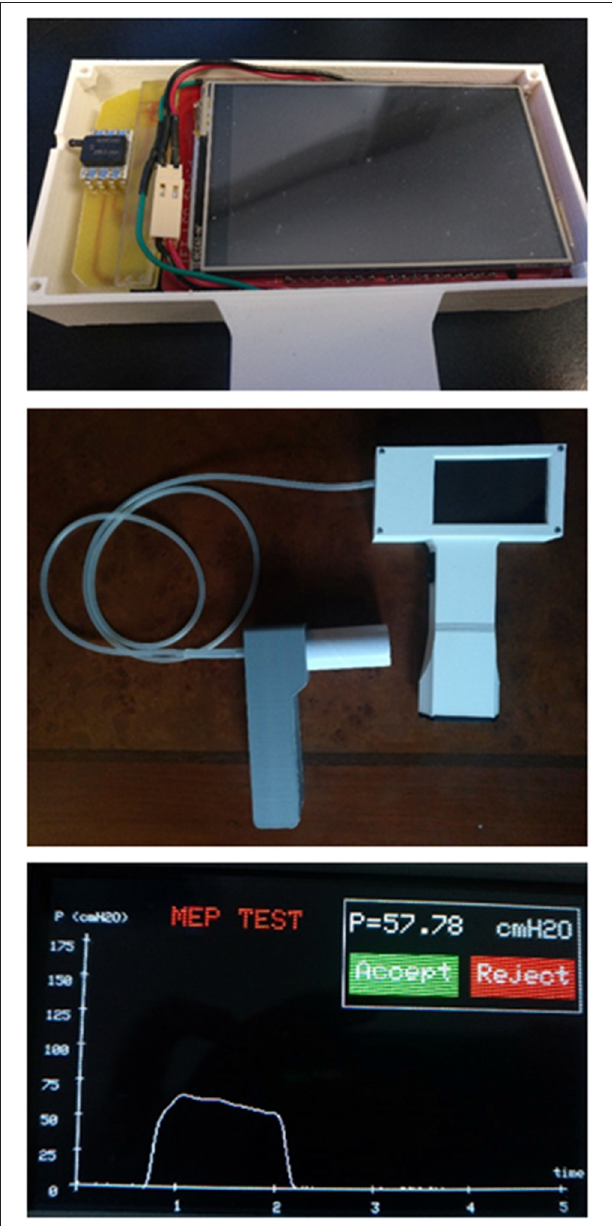
FIGURE 2 | (Top) Inside view of the MIP and MEP device prototype showing the operator enclosure, the pressure transducer, and the liquid crystal display (LCD) screen [on top of the Arduino controller (not visible)]. (Center) Complete external view of the device showing the operator hand-held block and the mouthpiece block for the patient, connected through a silicone flexible tube. (Bottom) Example of one of the screens during device operation, showing the result of an MEP maneuver test (time course of expiratory pressure, MEP result, and option to allow the user to accept or reject this specific maneuver).